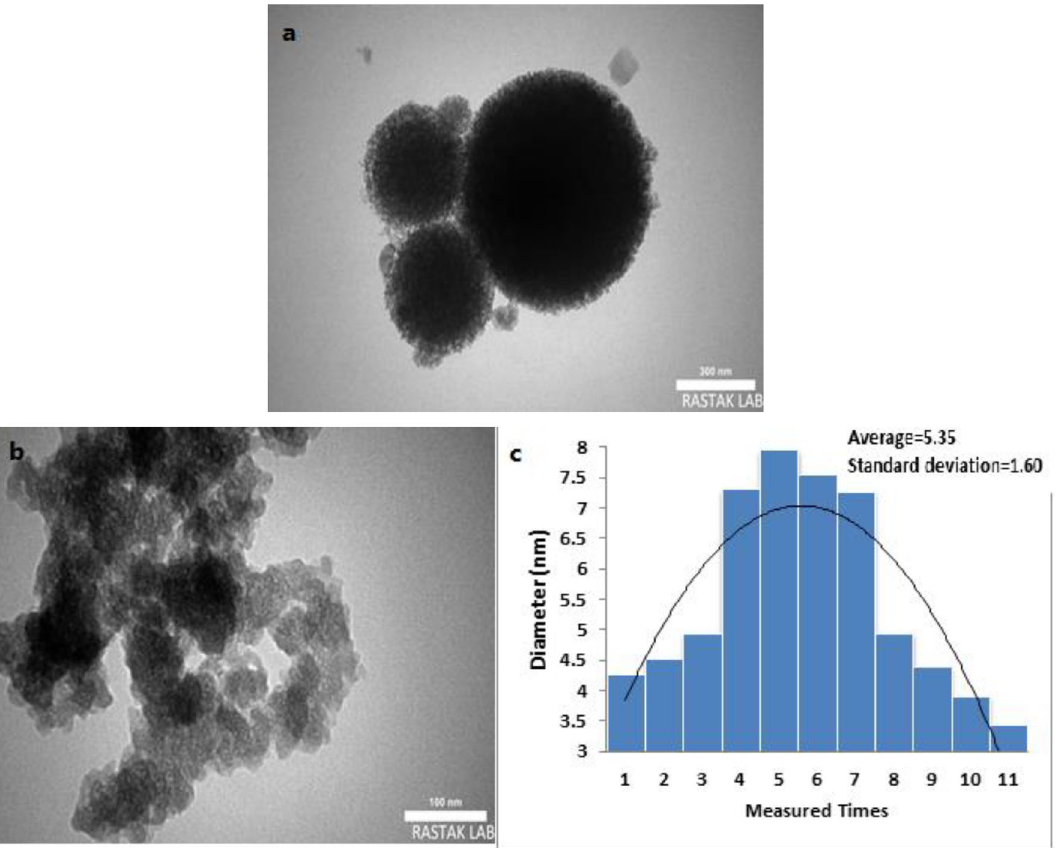
Figure 15. TEM images of HMS/Pr-PTSC-Cu ( a,b ), particle size distribution histogram of HMS/Pr-PTSC-Cu ( c ).